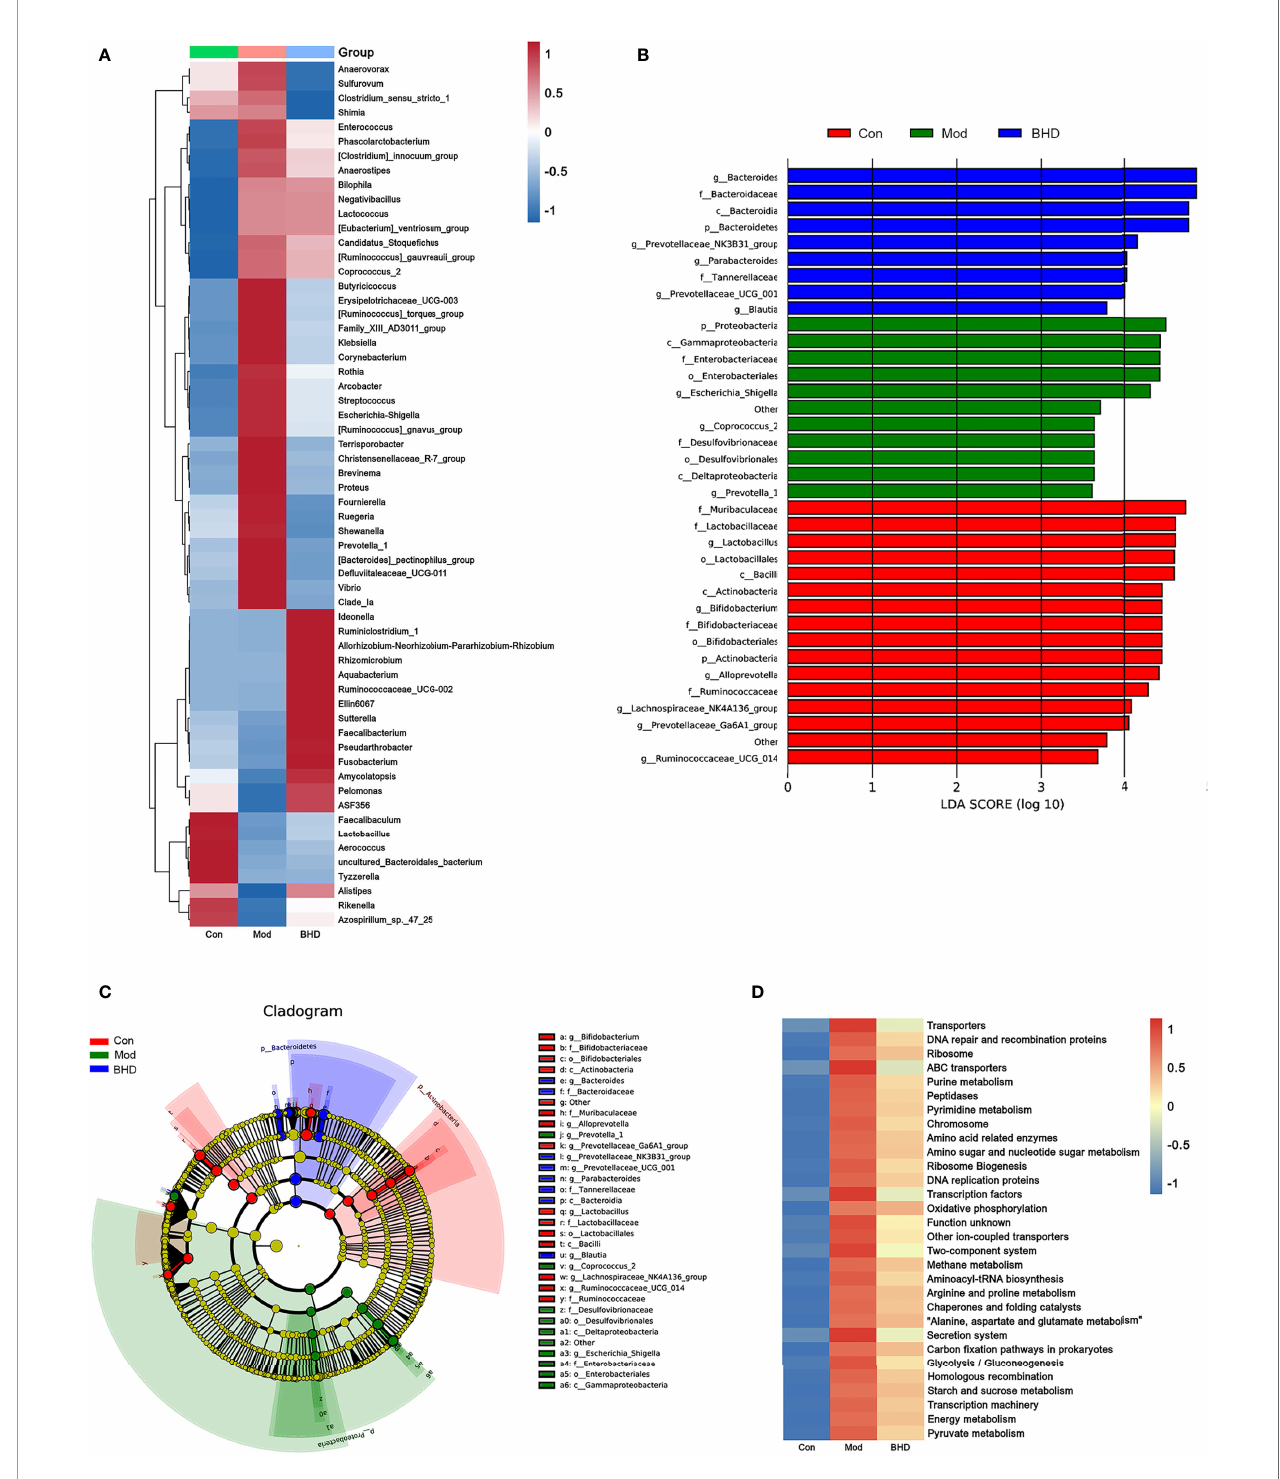
FIGURE 4 | BHD affected the relative abundances of gut microbiota members in rats with CI. (A) Relative abundances of differentially abundant bacterial taxa across the three groups at the genus level. (B) LDA score distribution of differentially abundant bacterial taxa. (C) Cladogram of differentially abundant bacterial taxa. (D) Abundances of KEGG metabolic pathways of the gut microbiota. n = 8 per